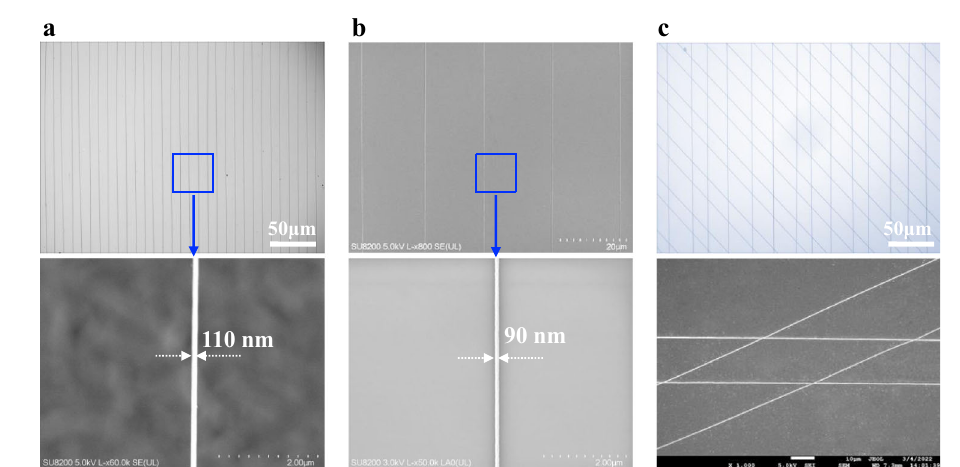
∼ 90nmanditshigh-magni fi cationimage. c Crossingwirestructuresprintedwitha width of ∼ 200nm and its high-magni fi cation